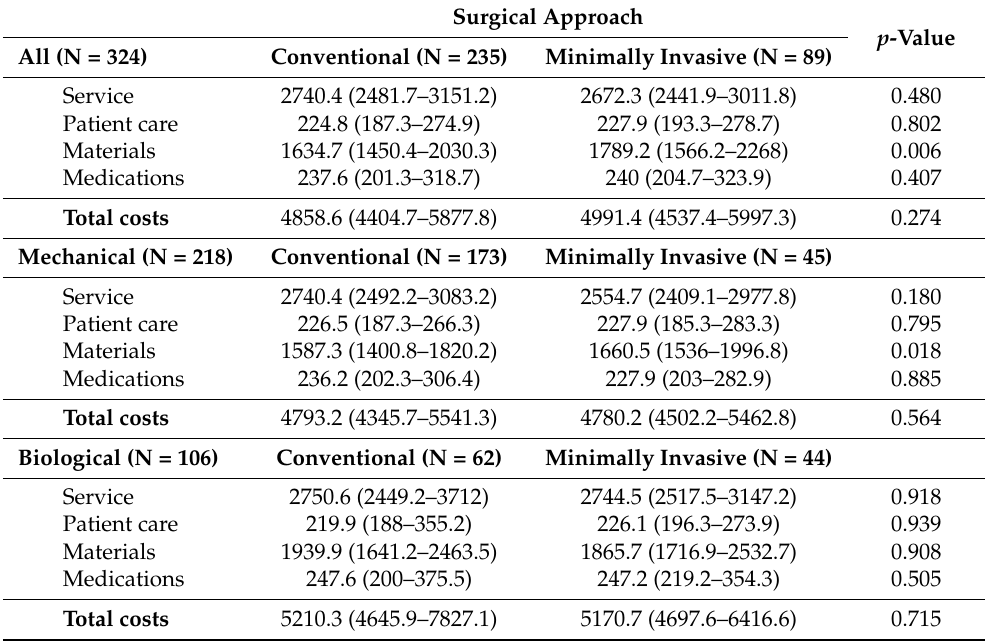
Table 6. Therapy costs